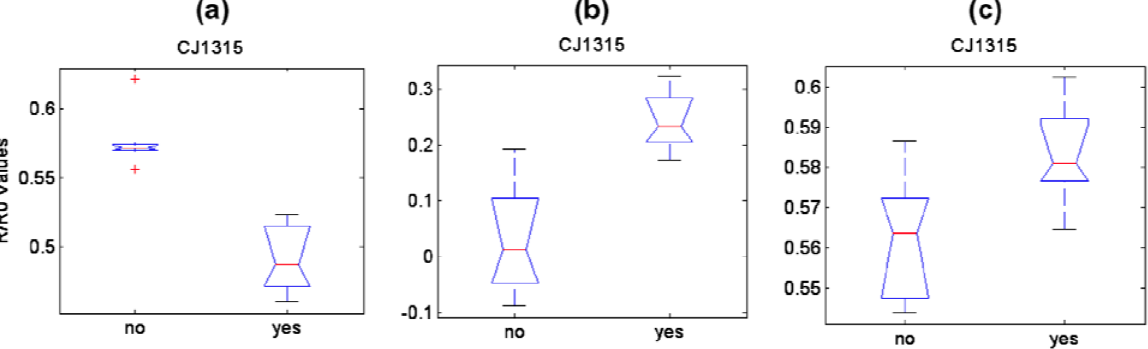
. Columns: ( a ) peach; 0